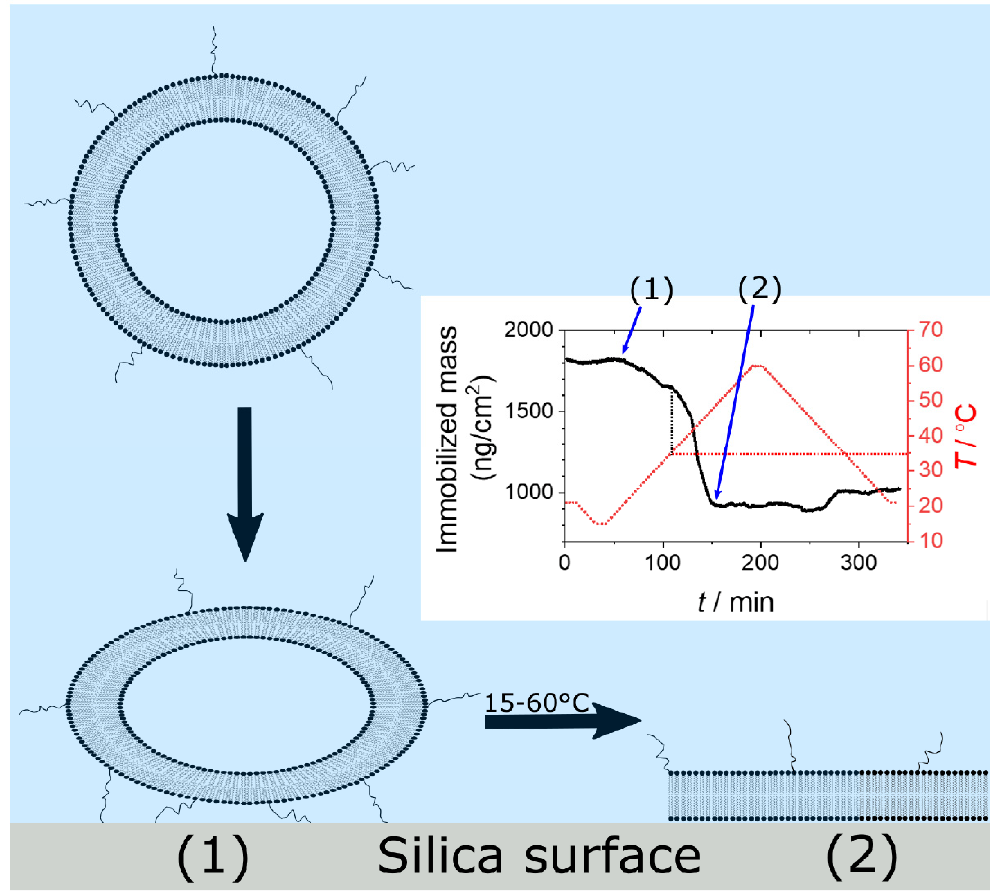
Figure 18. Schematic representation of the formation of supported lipid bilayers out of PEGylated liposomes, in the gel phase state, through temperature mediated rupture processes. The liposomes are attaching and rupturing on the surface (1) and form a supported lipid bilayer (2).